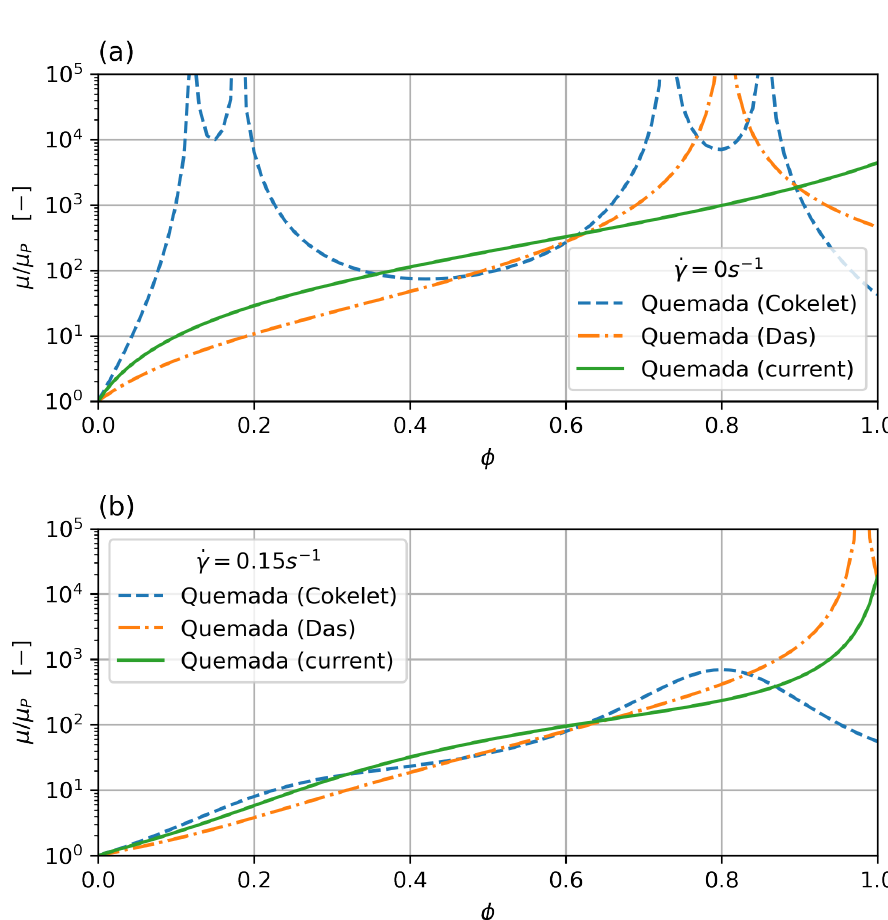
Figure 2. Comparison of Quemada parameterisation for zero ( a ) and low (0.15 s − 1 ) ( b ) shear rate. The classic Cokelet parameter set shows singularities at 12.2%, 18%, 73.1%, 85.6%, the modified parameterisation by Das improves on this, but still shows a singularity for 80.4% haematocrit. The current parameter set removes the singularity and shows monotonous